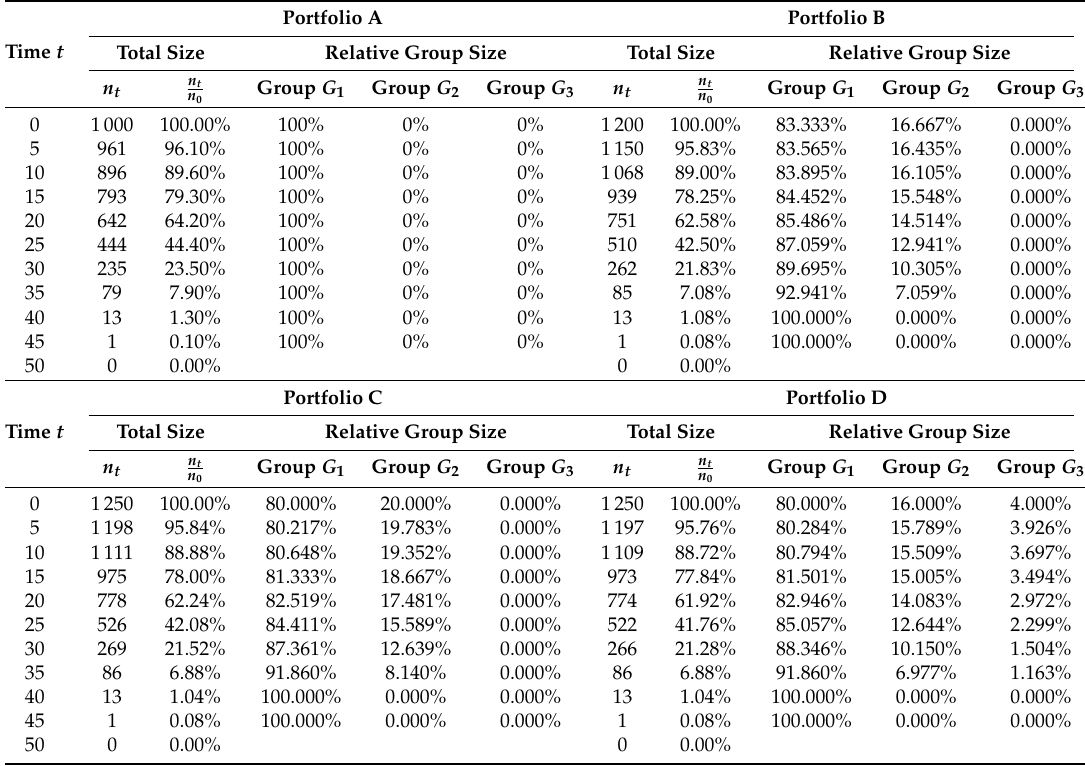
Table 9. Portfolio size and